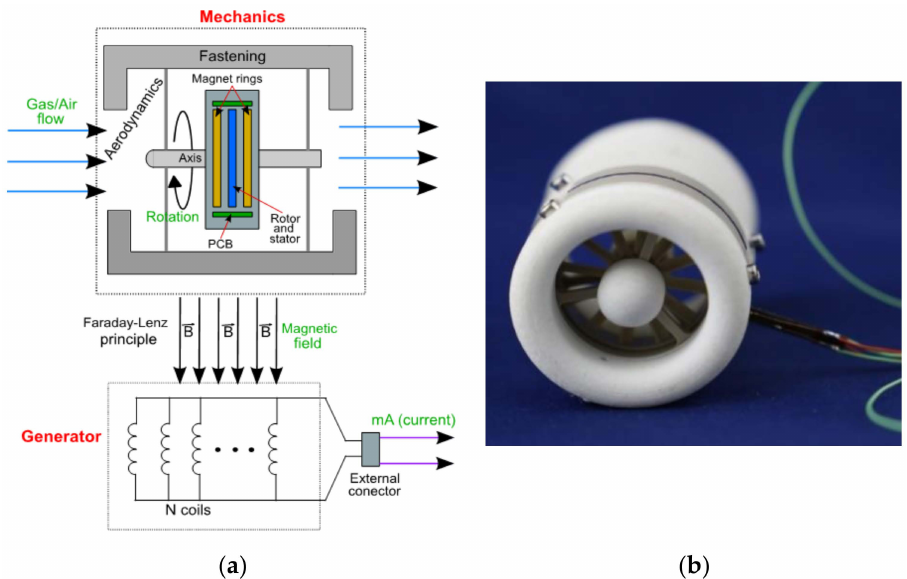
Figure 2. Used wind energy harvester and its operation diagram. ( a ) Operation diagram. ( b ) Mini wind energy harvester (Inside diameter 22.7 mm, and outer 27.7 mm).